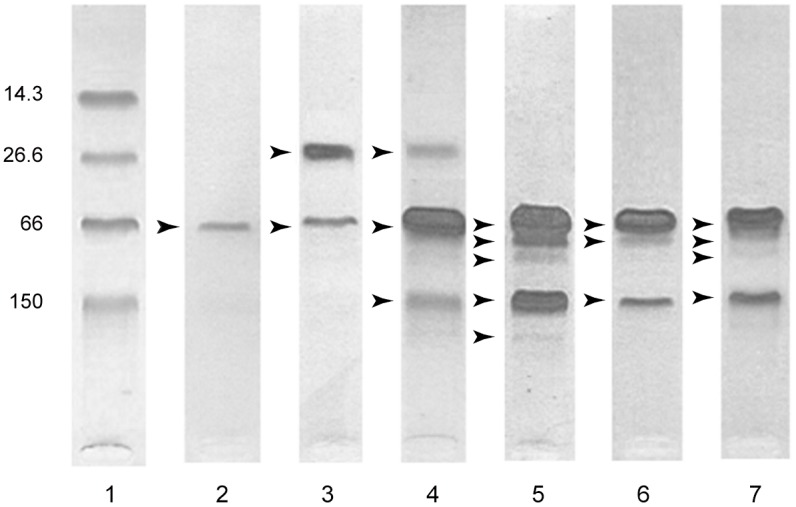
Example of the different results for SDS-AGE performed on urine.Lane 1 represents the migration of molecular markers, lane 2 a normal pattern, lane 3 a tubular pattern, lane 4 an abnormal mixed pattern, lane 5 an abnormal glomerular pattern from the non azotemic dog with confirmed familial GN. Lanes 6 and 7 both represent glomerular pattern from dogs with stage II and III CKD respectively. The various protein bands identified are indicated by arrowheads. The numbers on the left side correspond to molecular weight of molecular markers in kDa.